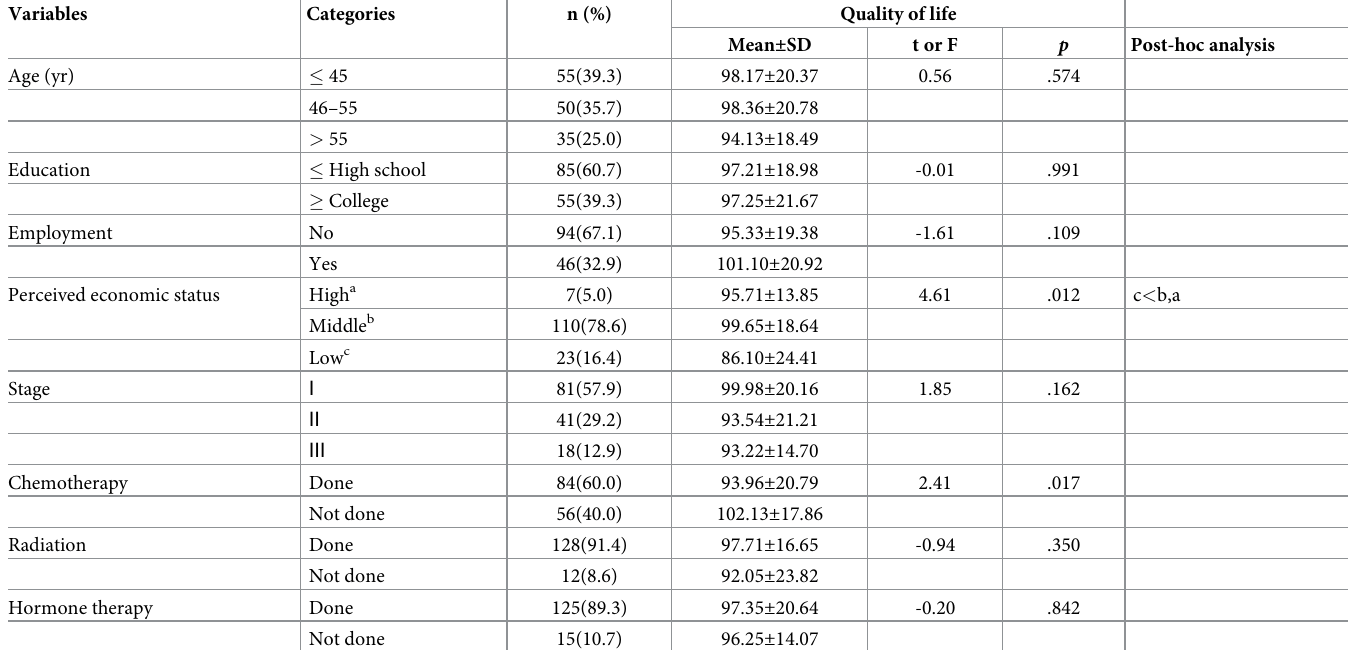
Table 1. Differences of quality of life according to sociodemographic and disease/treatment-related characteristics (N = 140). Variables